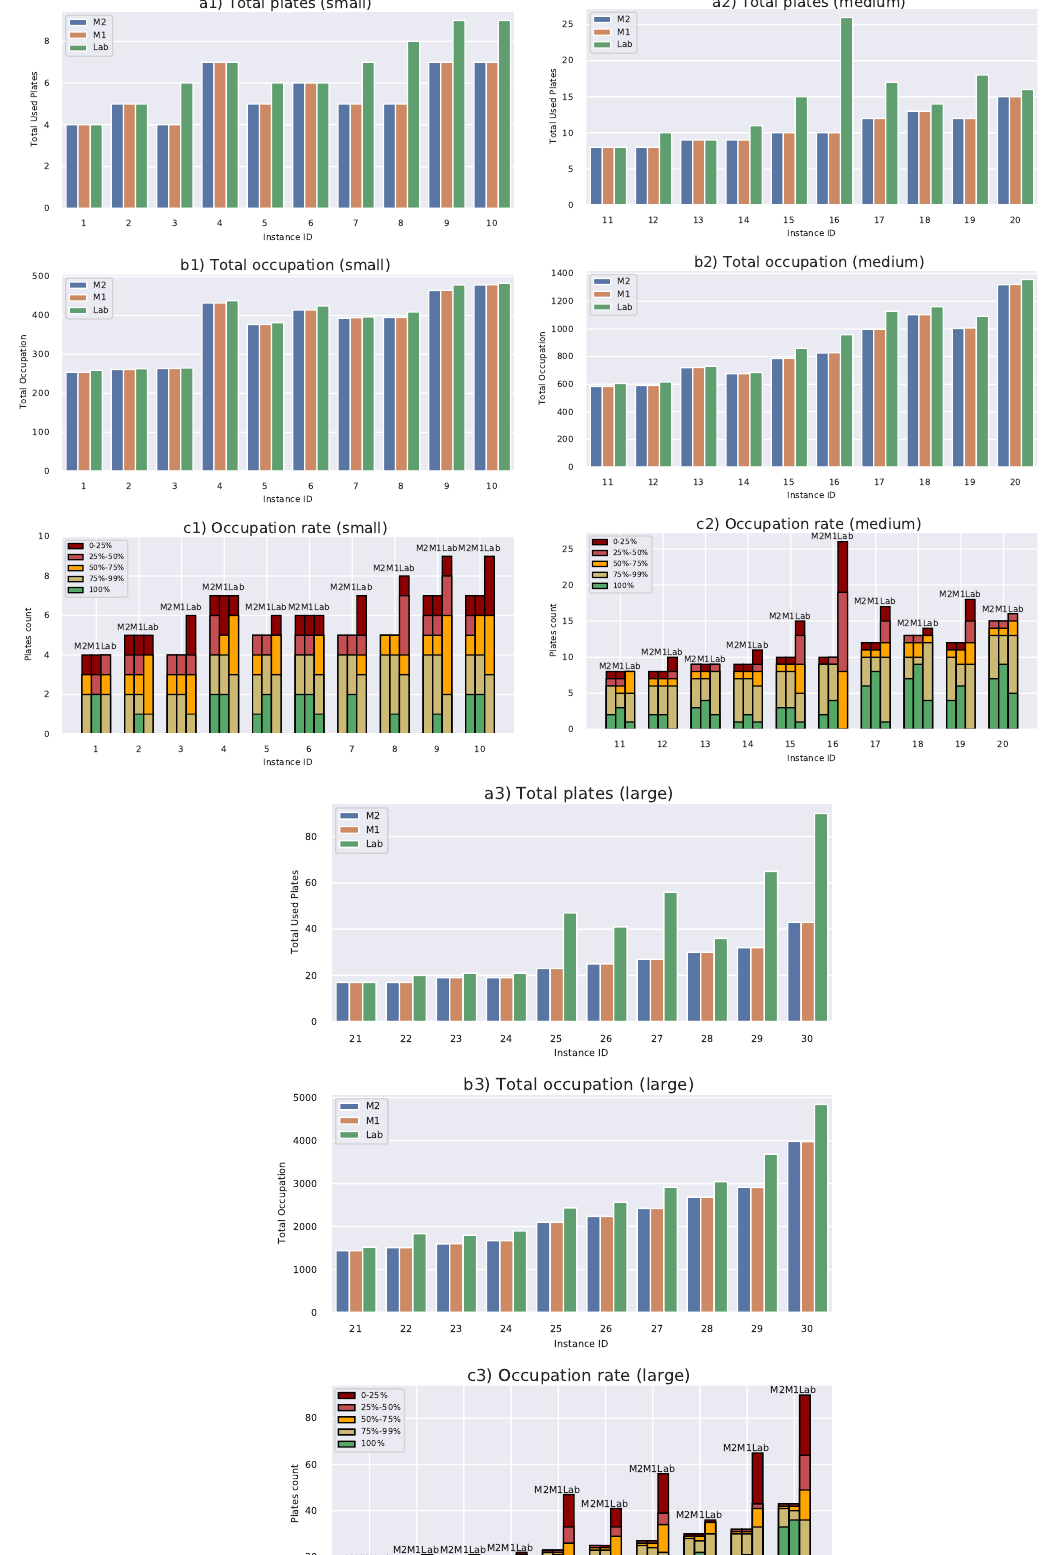
Figure 18. Comparison between M1, M2 and Labware for all available